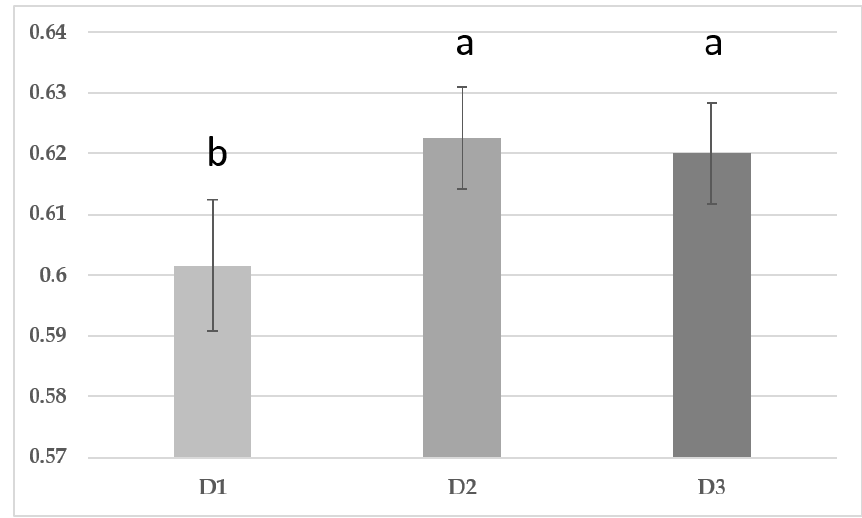
Figure 2. Effect of biochar application rates (D1 = 10, D2 = 20, D3 = 40 t ha − 1 DM) on the 2019 NDRE index at 77 DAS. a,b Values with different letters are significantly different at the 0.05 level of probability by Stu-dent–Newman–Keuls test. Table 5. Italian ryegrass yield in the two productive cycles 2018–2019 and 2019–2020; mean values and SE; ANOVA results. The crop was not fertilized; the treatments applied to the previous silage maize culture are